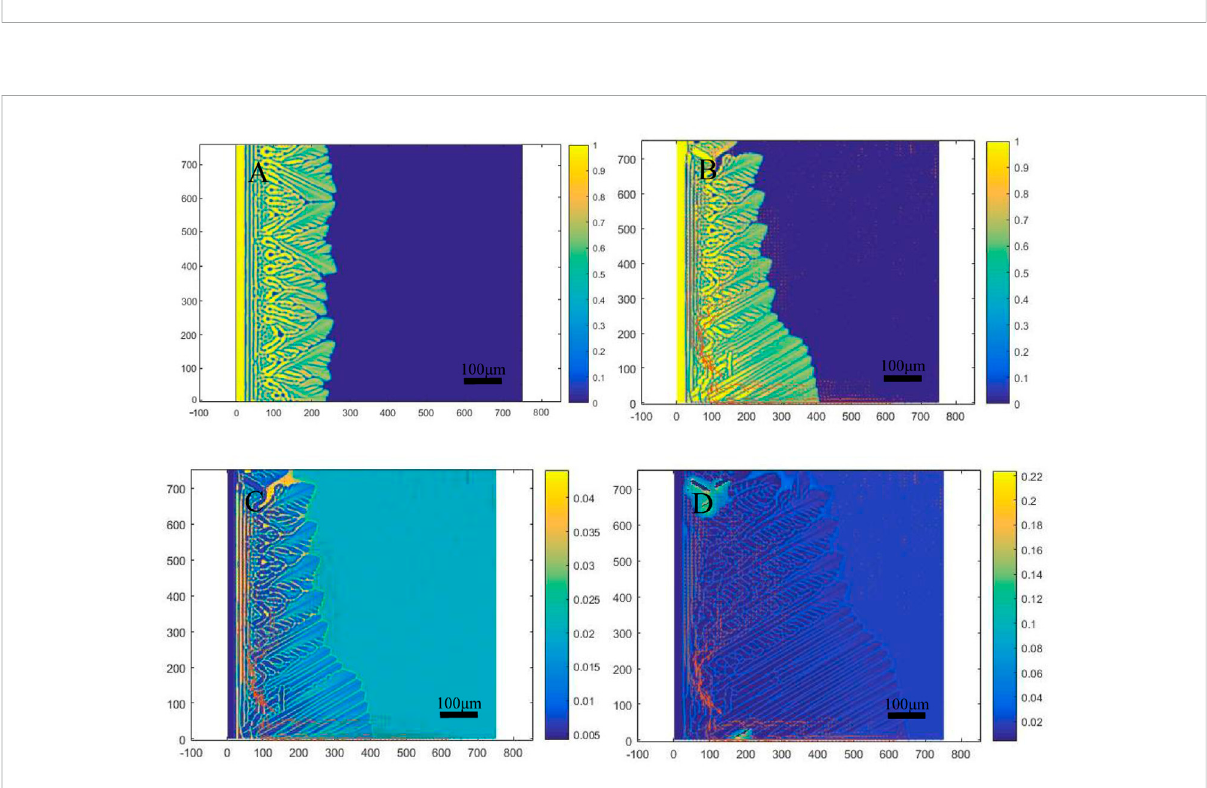
CET transformation process.